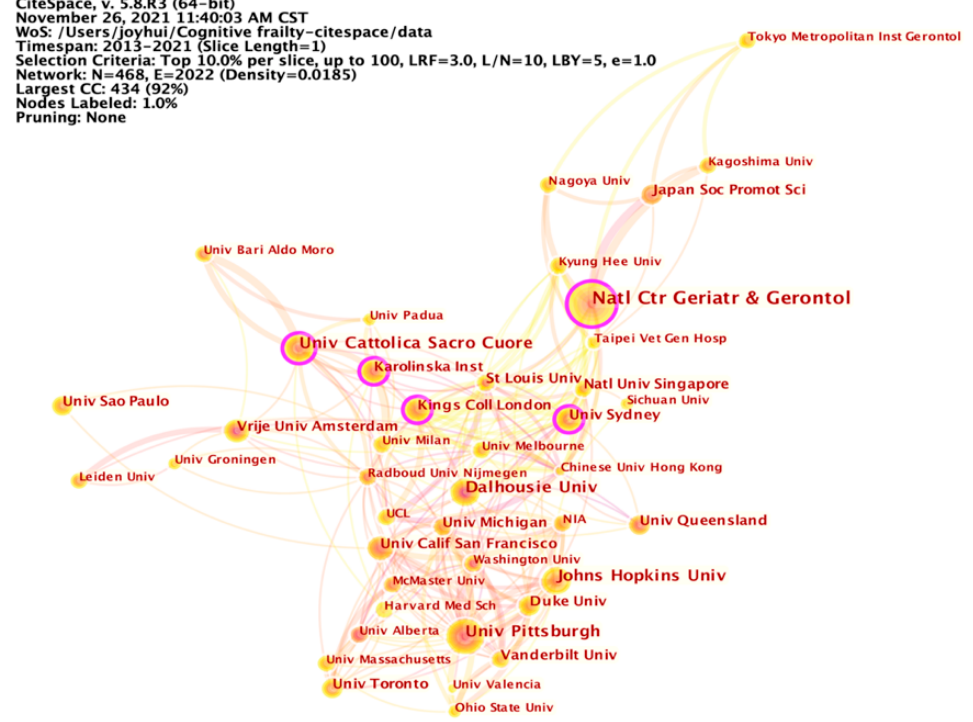
Figure 3. Collaboration network of institutions. Università Cattolica del Sacro Cuore, King’s College London, the University of Sydney, the Karolinska Institute, and the National Center for Geriatrics and Gerontology closely cooperated with other institutions in cognitive frailty research.